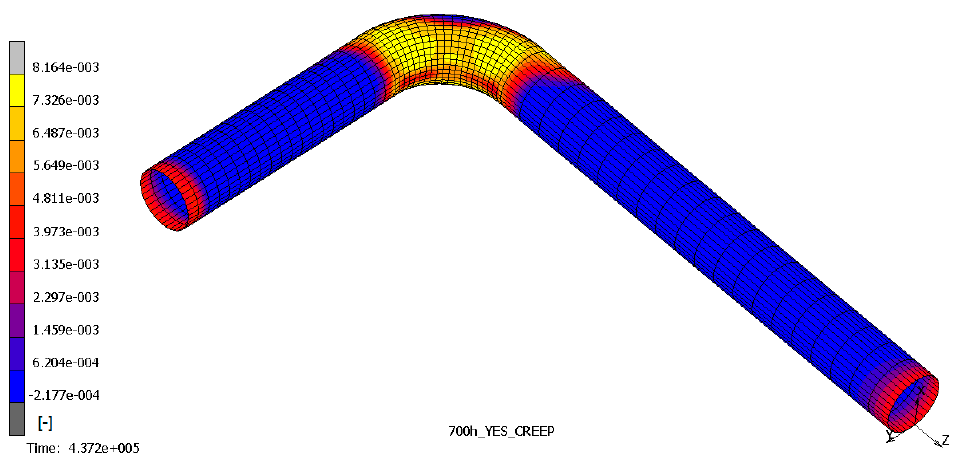
Figure 8. Total equivalent creep strain—case 5.